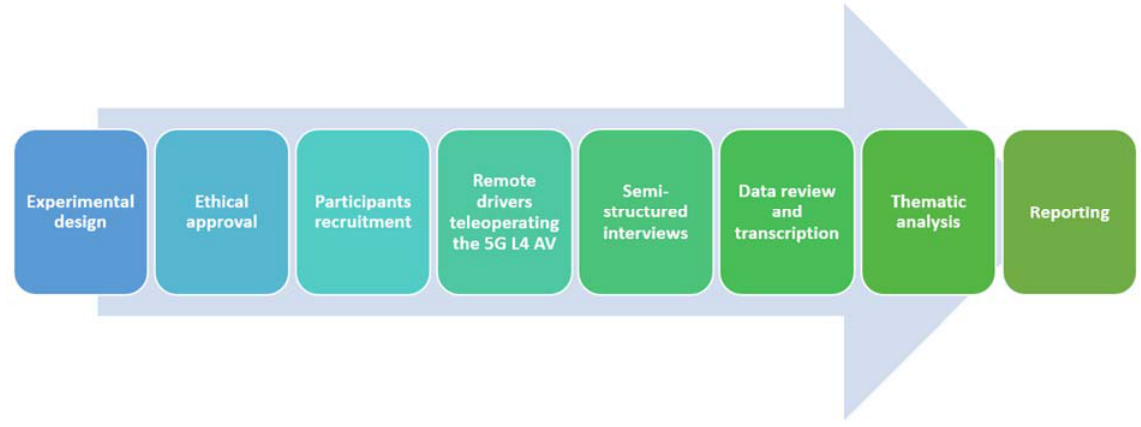
Figure 3. Illustration of research process.